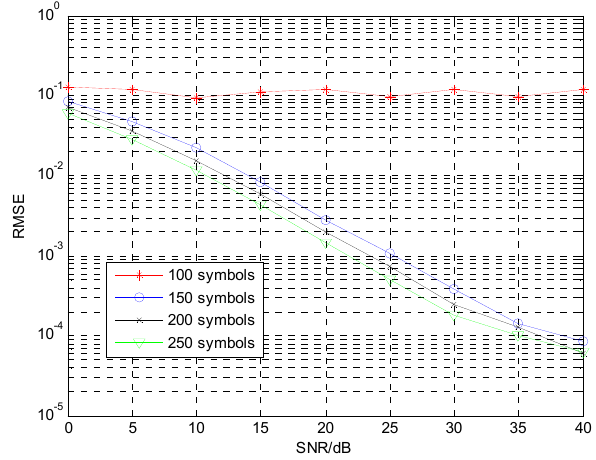
200 N = is very robust. s